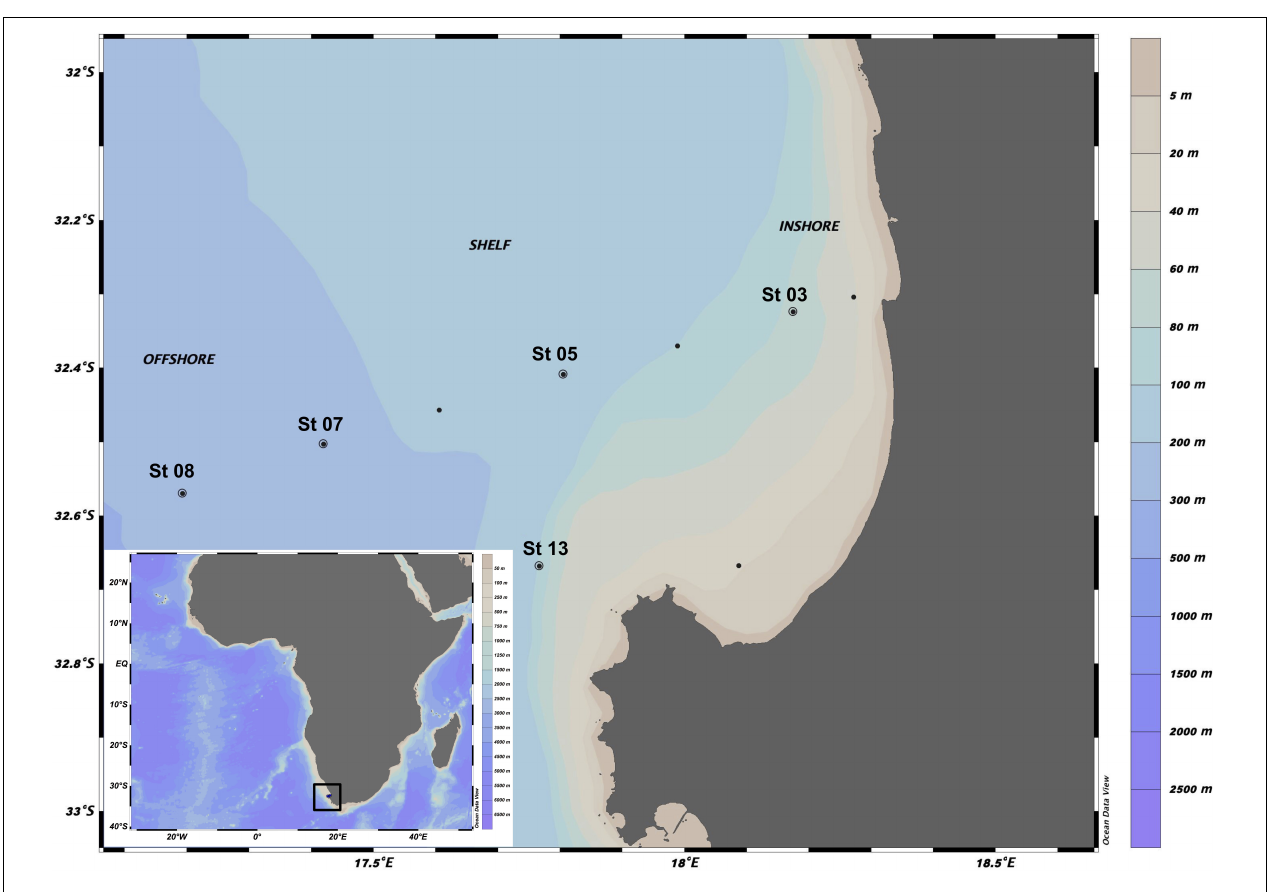
FIGURE 1 | Map illustrating St Helena Bay and the five stations (3, 5, 7, 8, and 13) that were sampled for the present study.